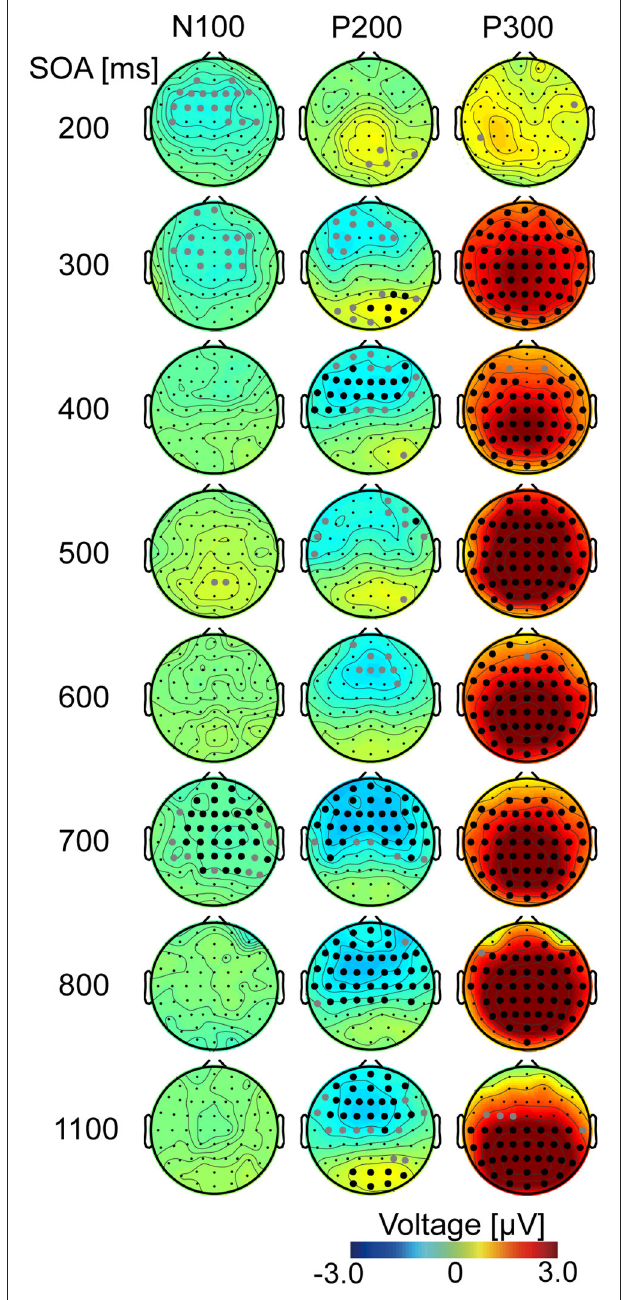
FIGURE 3 | Topography of ERP difference (target – non-target). Differences in ERPs were calculated from averaged EEG data for all participants. Each row represents one of the eight SOA conditions and shows difference maps at each latency for N100, P200, and P300 (Supplementary Table 1). White and gray filled circles represent channels that showed statistically significant differences ( p < 0.05) with and without FDR correction, respectively.